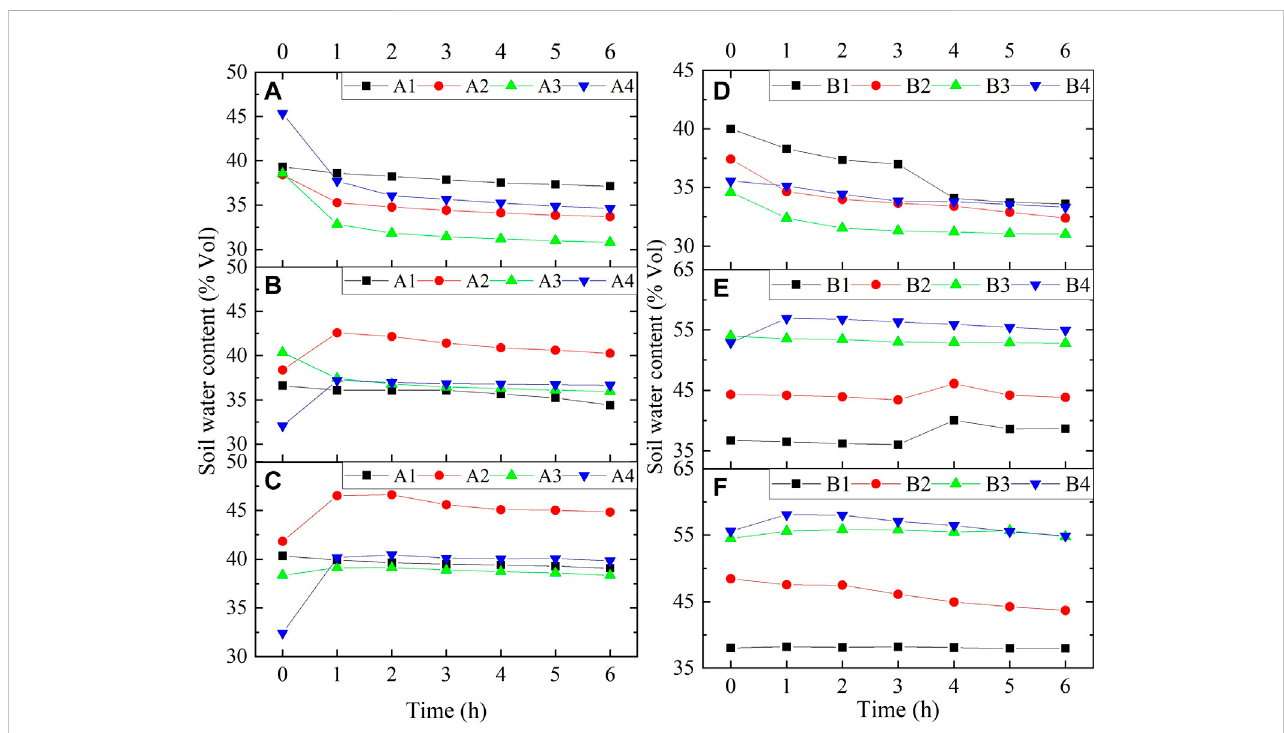
FIGURE 5 Redistributions of soil water content in experimental plots at 10 – 70 cm depth from 1 to 6 h after rainfall ended [ (A – C) indict the SWC in the 10 – 30, 30 – 50, and 50 – 70 cm soil under 100 mm/h rainfall intensity, respectively, while (D – F) indict the SWC under 50 mm/h rainfall